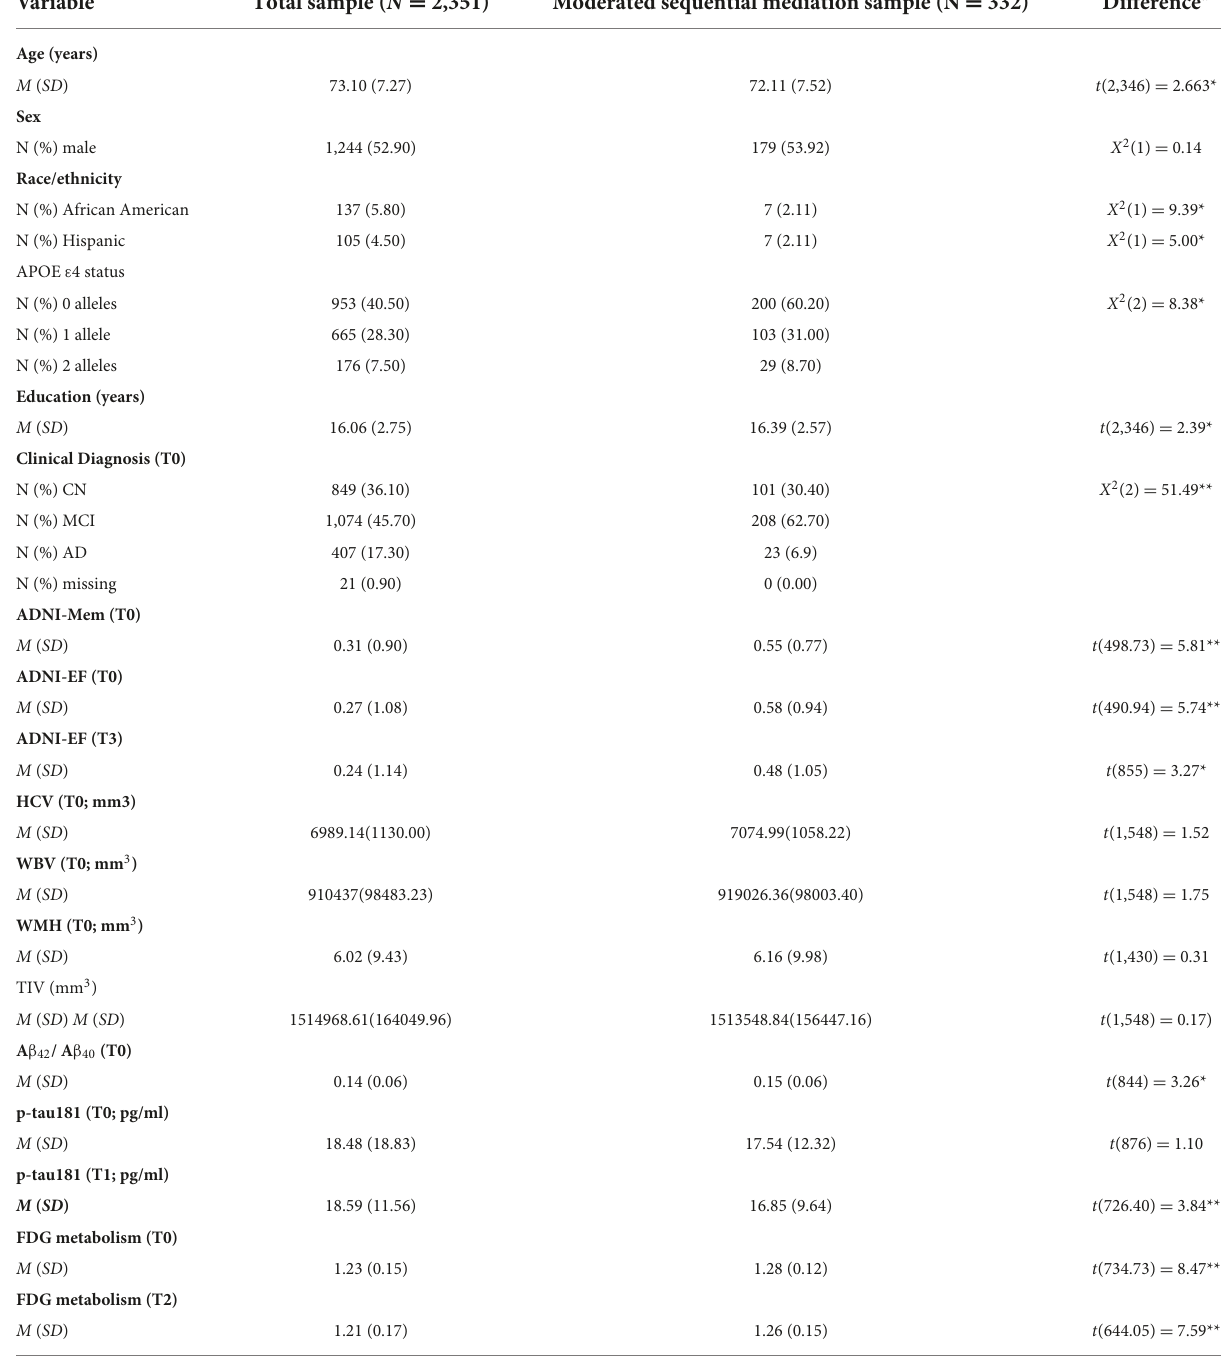
TABLE 1 Participant